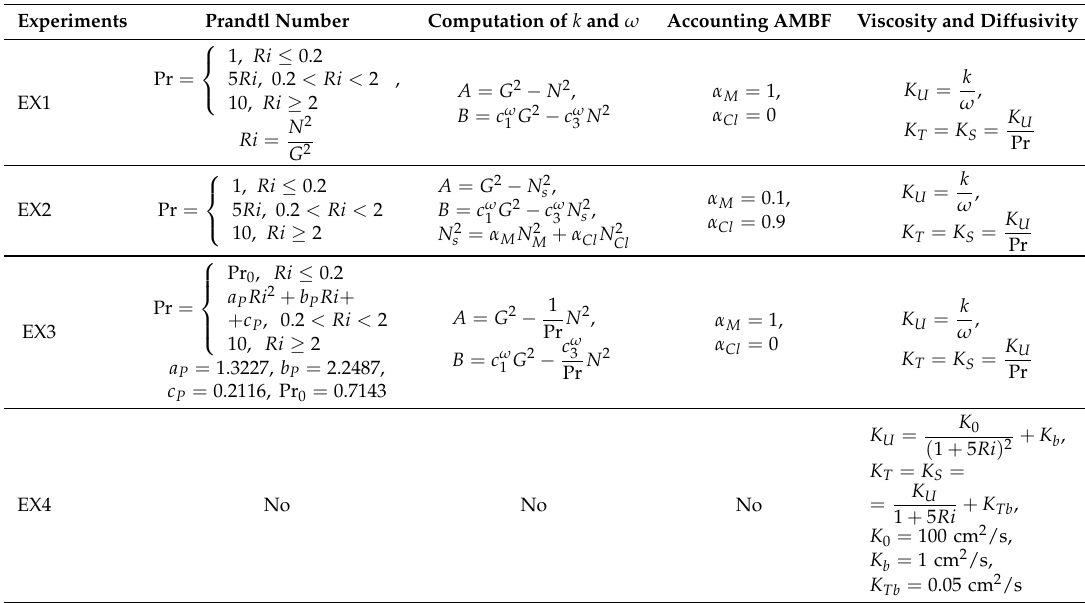
Table 1. Model parameters corresponding to the numerical experiments